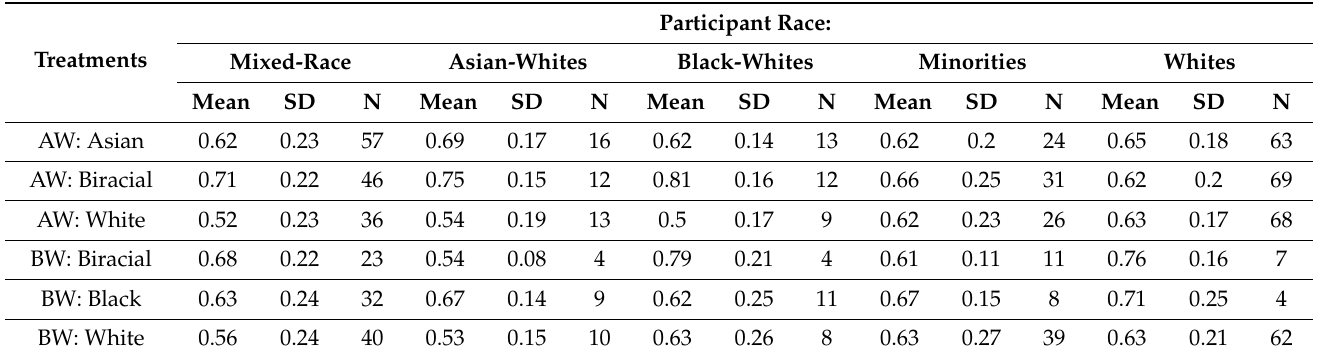
Table A3. (Vote Intention) Mean, standard deviation, and sample size information for each treatment condition × participant race cell.